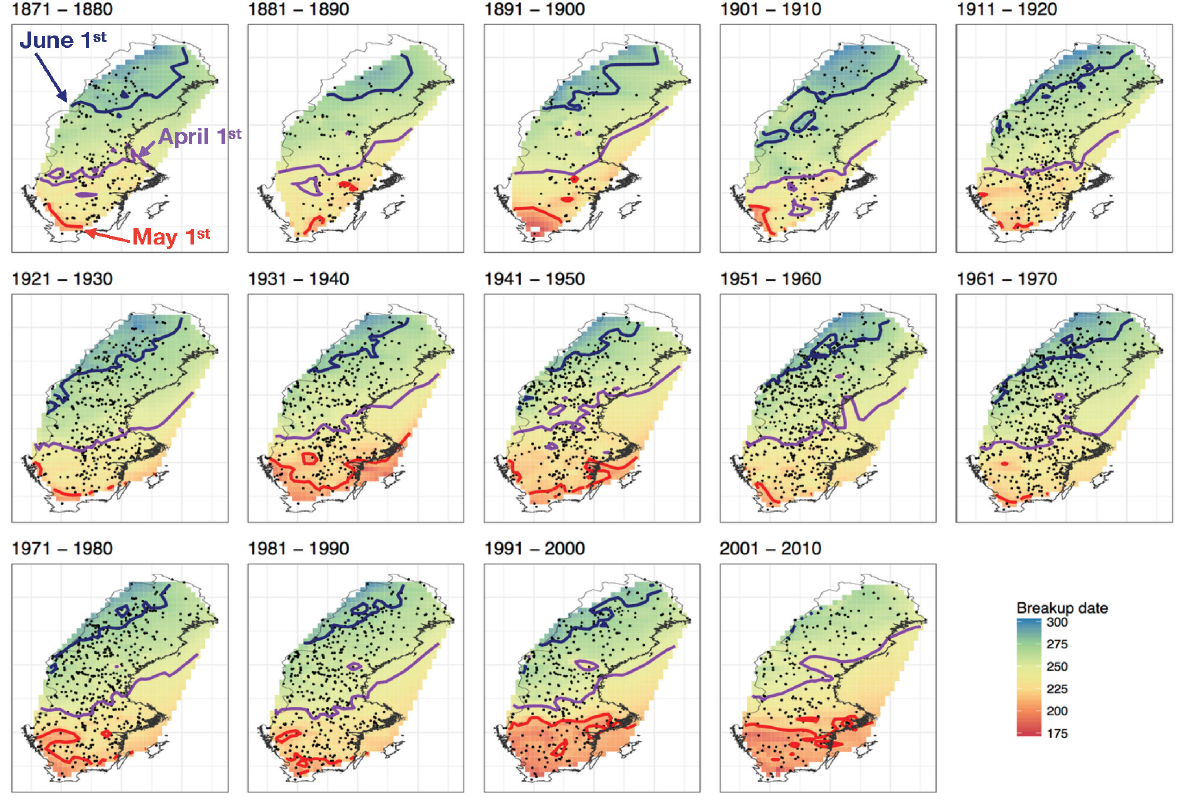
Figure 1. Mean ice break-up date in Sweden over 10-year periods from 1871 to 2010. The gray line represents the outline of Sweden. Shading represents the number of days after 31 August when ice break-up occurs. The blue, purple, and red contour lines represent a break-up date by the 1 June, 1 May, and 1 April, respectively. Black dots indicate the observation sites for each 10-year